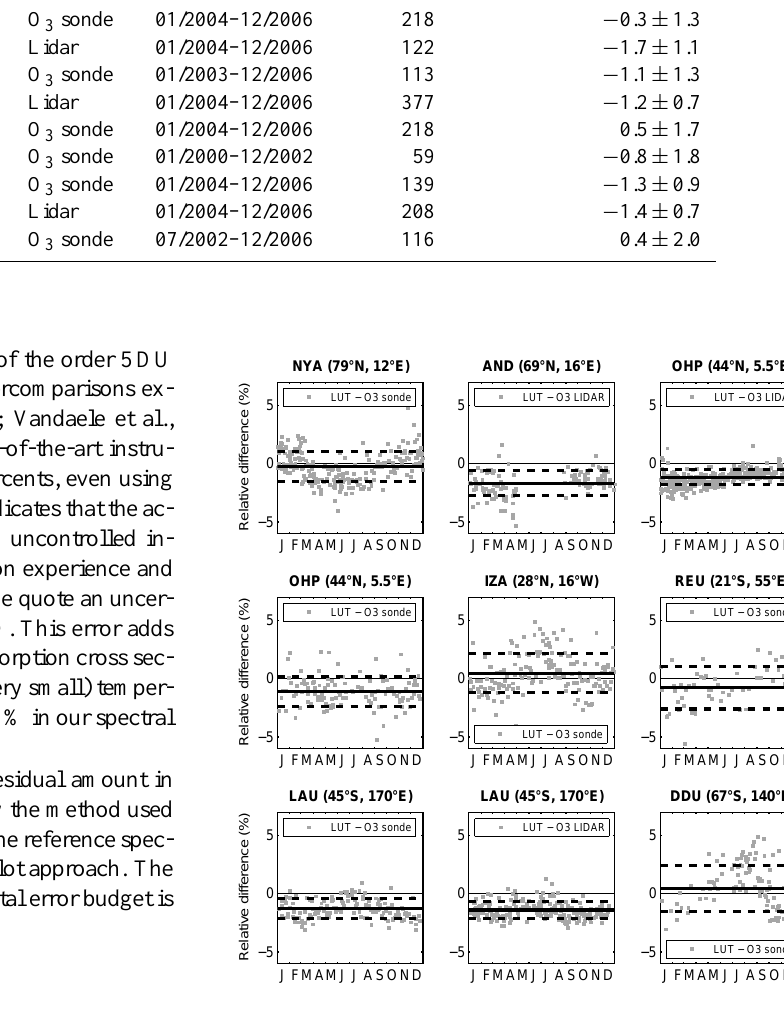
Fig. 4. Relative difference between O 3 AMF 86 − 91 ◦ SZA extracted from the LUTs and calculated using the O 3 profiles measured at the following NDACC stations: Ny- ˚Alesund (NYA), Andoya (AND), Observatoire de Haute Provence (OHP), Iza˜na (IZA), Reunion Is- land (REU), Lauder (LAU), and Dumont d’Urville (DDU). Filled grey squares: daily relative differences, black solid lines: yearly mean relative difference, and black dashed lines: 1 σ standard devi- ation (see Table 3 for corresponding